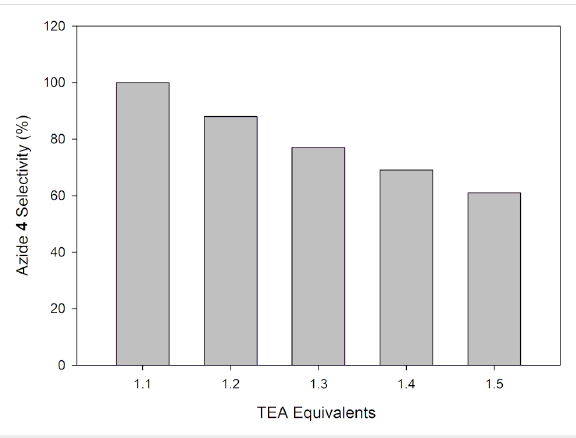
Figure 10: Effect of TEA concentration on the reaction selectivity.